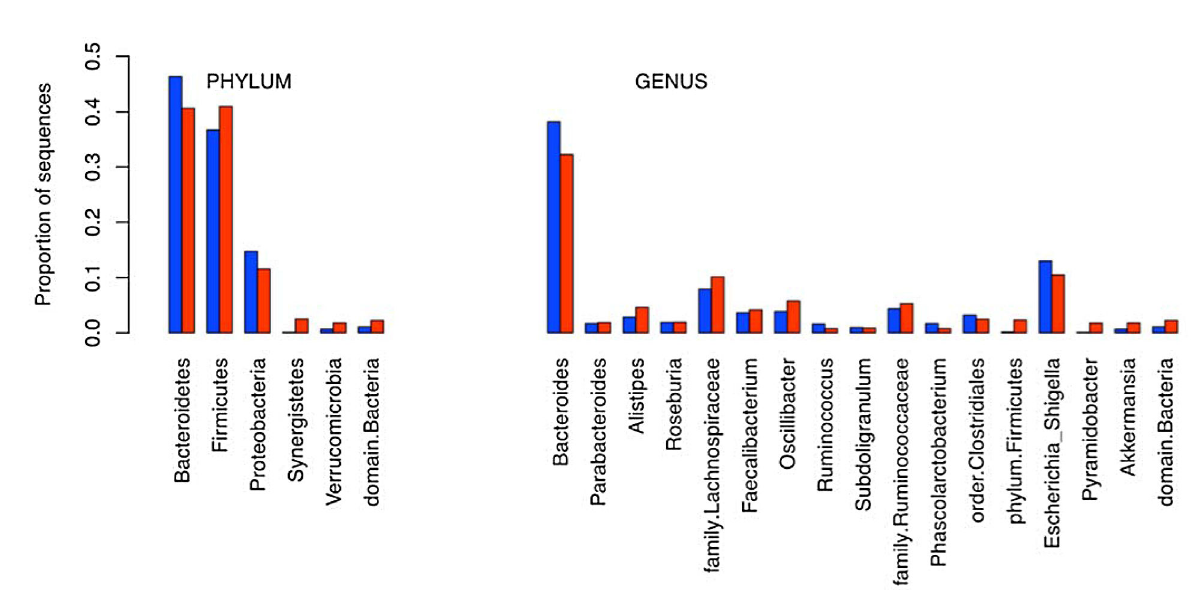
Figure 4. Bacterial phyla and genera distribution in healthy (Blue) and colon polyps (Red) patients’ samples based on 454 pyrosequencing data.